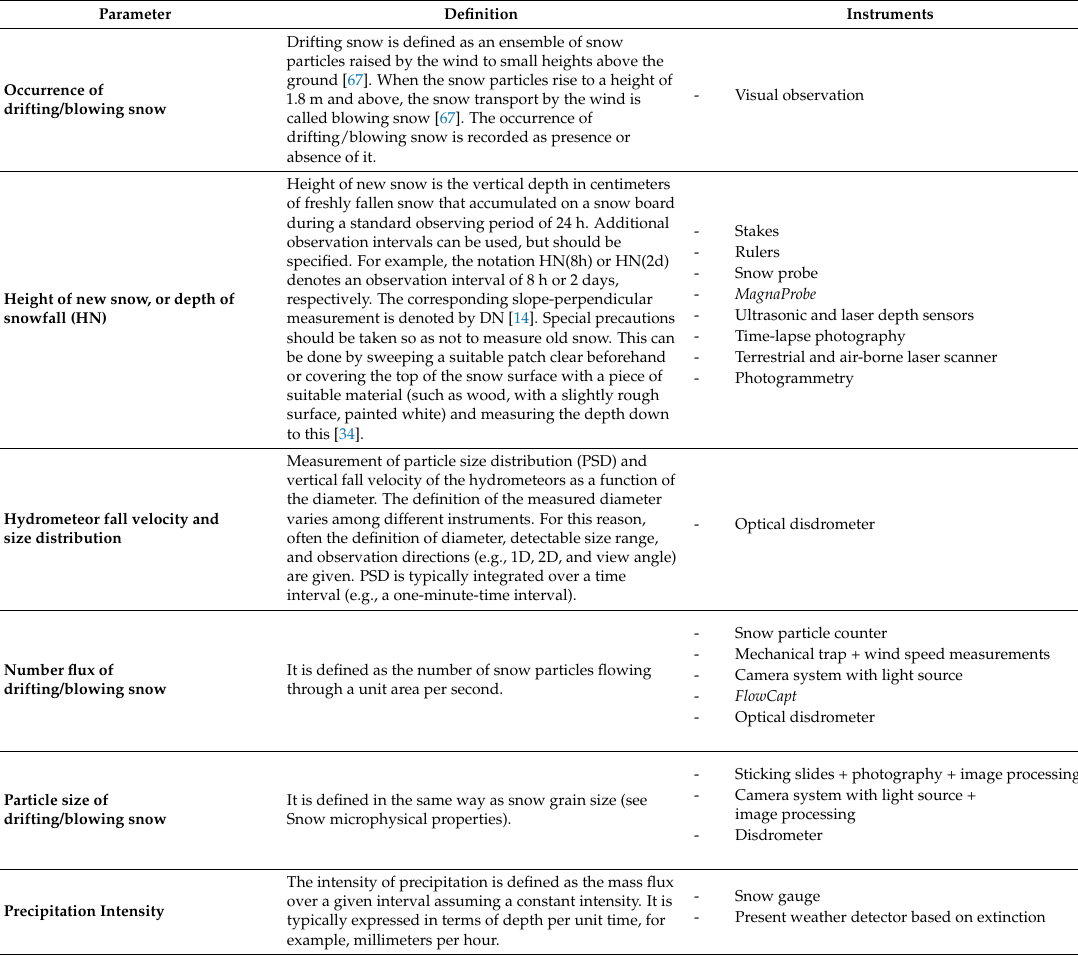
Table A4. List of measurable properties associated with precipitating and suspended snow: name of the properties (first column), definition (second column), and existing instruments.